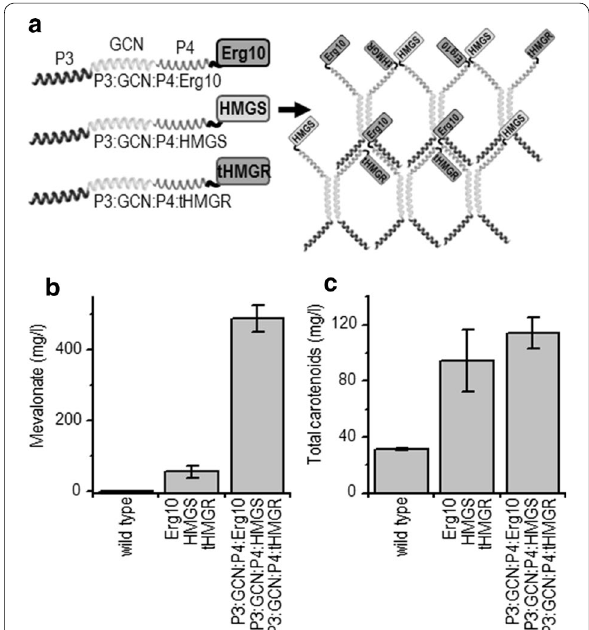
Fig. 5 A coiled-coil dimer-based scaffold linked to mevalonate biosynthesis enzymes improves mevalonate accumulation in S. cerevisiae . a Scheme for the designed coiled-coil-based polypeptide scaffold. Extracellular mevalonate production ( b ) and total carotenoid accumulation ( c ) in carotenoid-producing yeast cells. The wild type is strain CAR-0002. CAR-0002 transformants express non-fused mevalonate pathway enzymes (Mev: ERG10, HMGS, or tHMGR) or coiled-coil scaffolded proteins (P3:GCN:P4-Mev). The data represent the average and standard deviation for mevalonate or the total carotenoid measurements for three independent transformants grown in